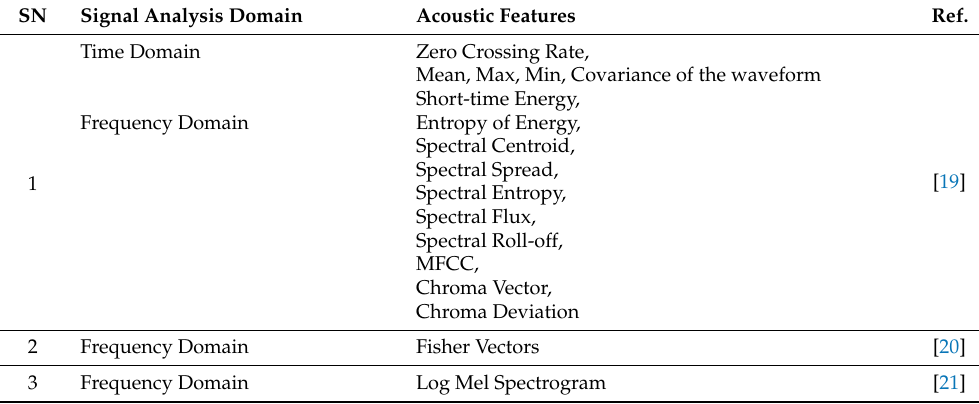
Table 2. Baseline GMM acoustic features.